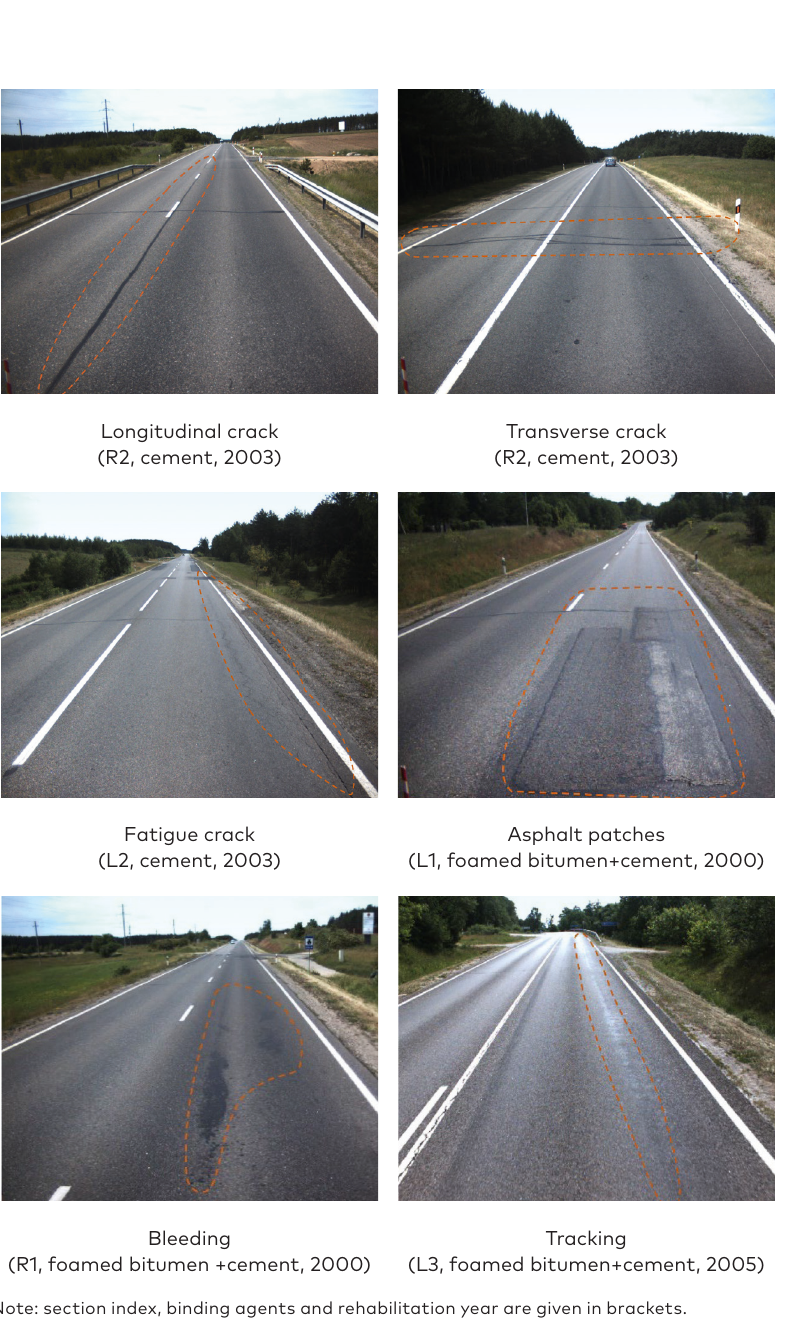
Figure 6. Pavement surface distress observed on analysed road